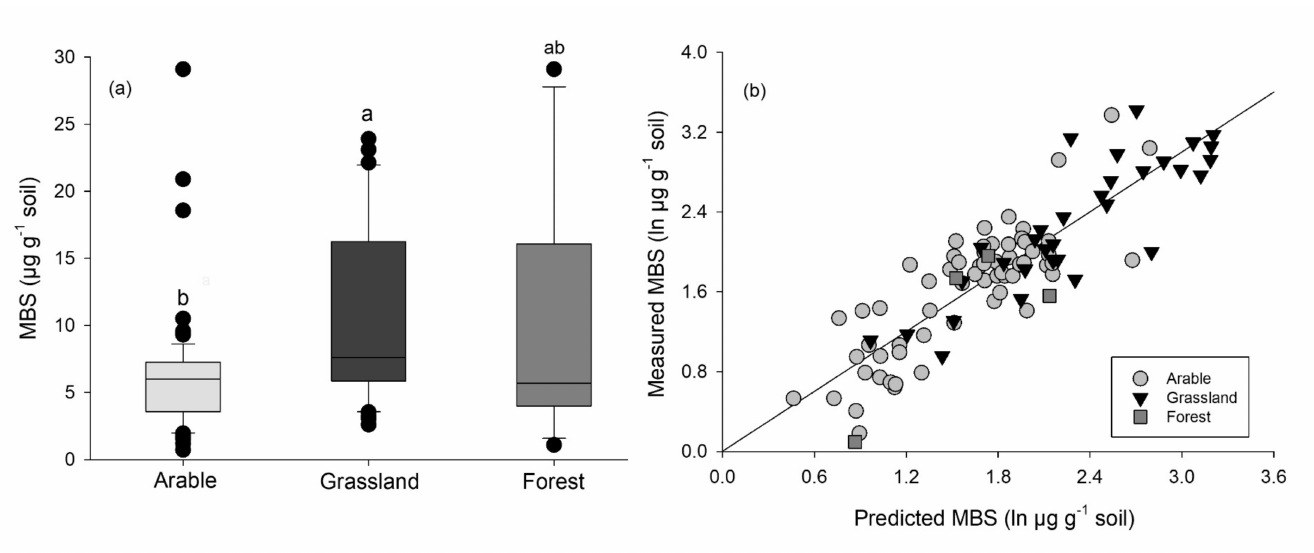
Figure 1. ( a ) MBS contents ( µ g g − 1 soil) in arable ( n = 77), grassland ( n = 41), and forest soils ( n = 11), different letters on top of outliers or whisker caps indicate a significant difference ( p < 0.05, Holm-Sidak test); ( b ) multiple linear relationship between measured MBS as a dependent variable and predicted MBS by MBC and soil pH in water as an independent variable: ln MBS = − 4.010 *** + 0.782 *** × ln MBC + 0.127 *** × pH-H 2 O, n = 102, adjusted r 2 = 0.77 ***; *** p <